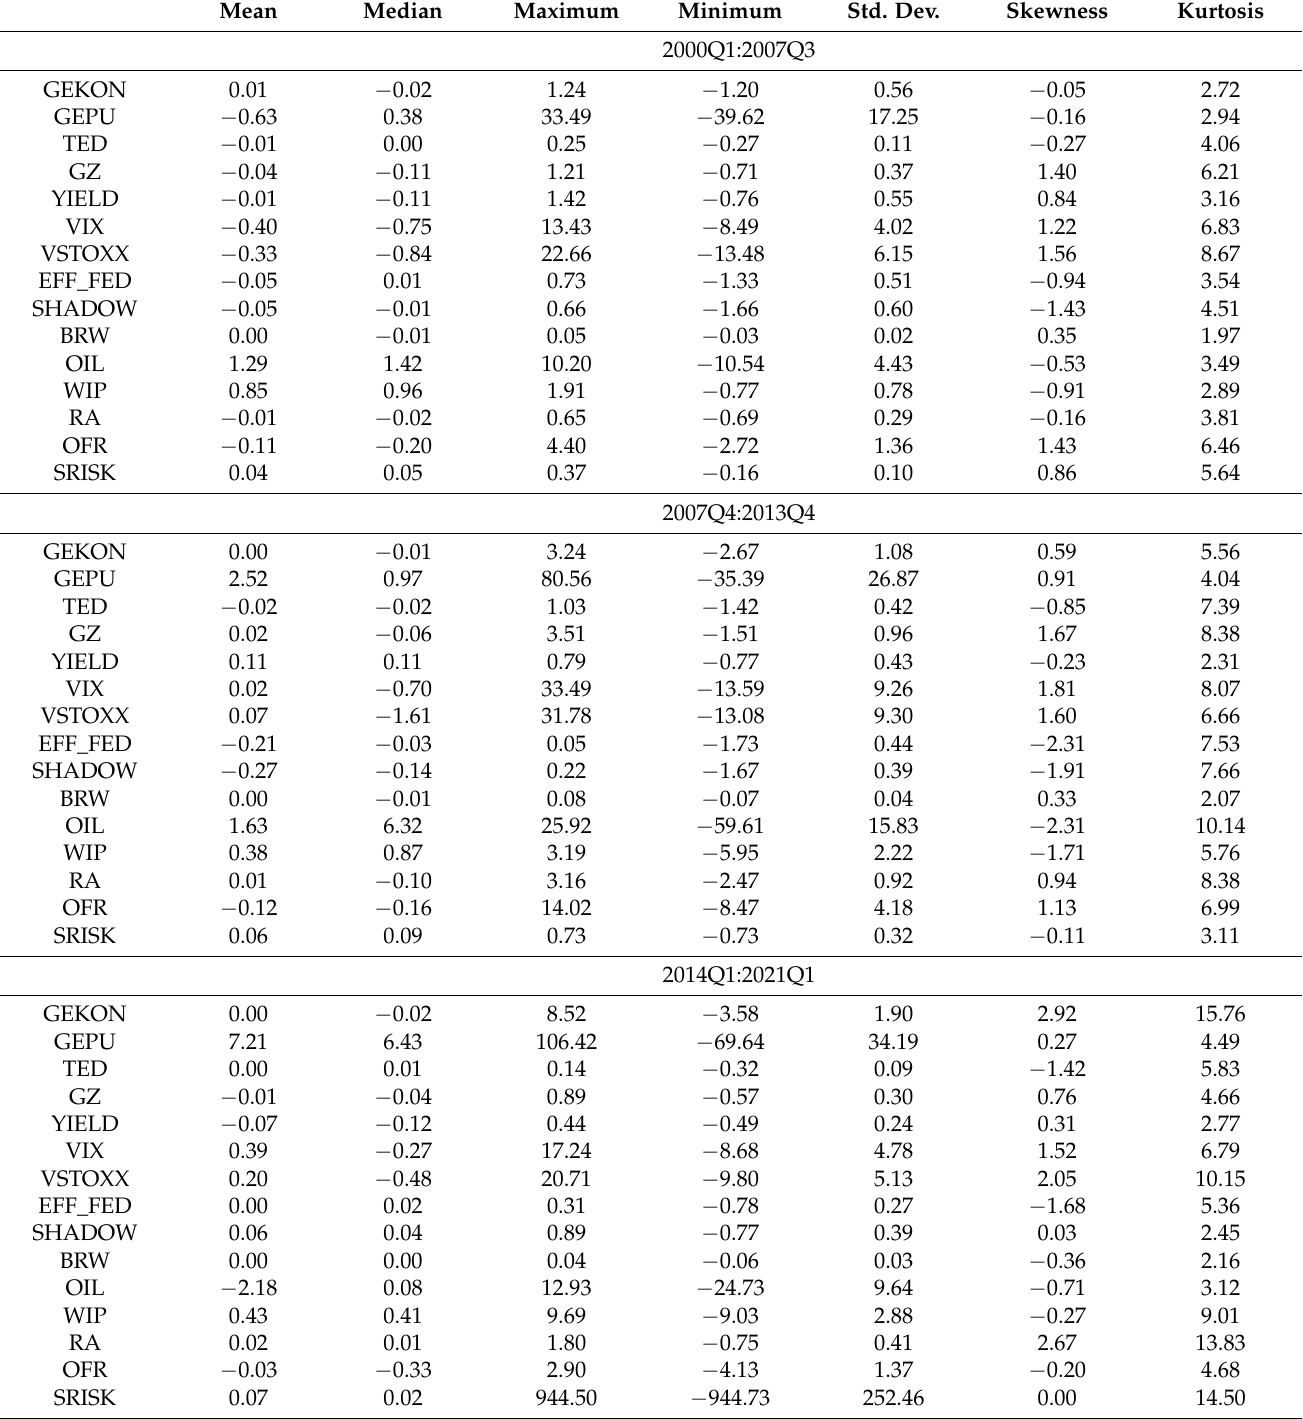
Table A3. Descriptive statistics for global